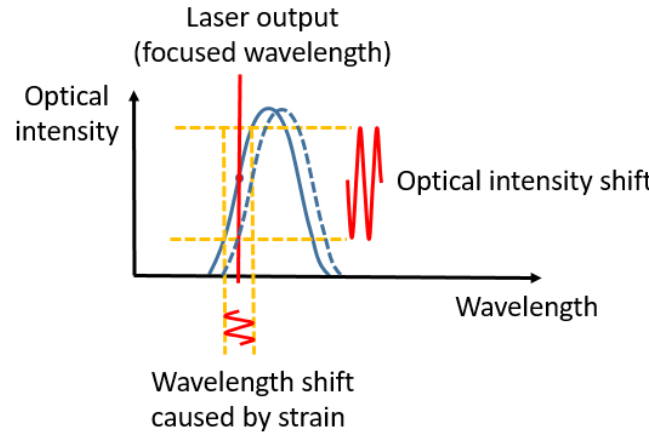
Figure 2. Principle of edge filter demodulation method [13].